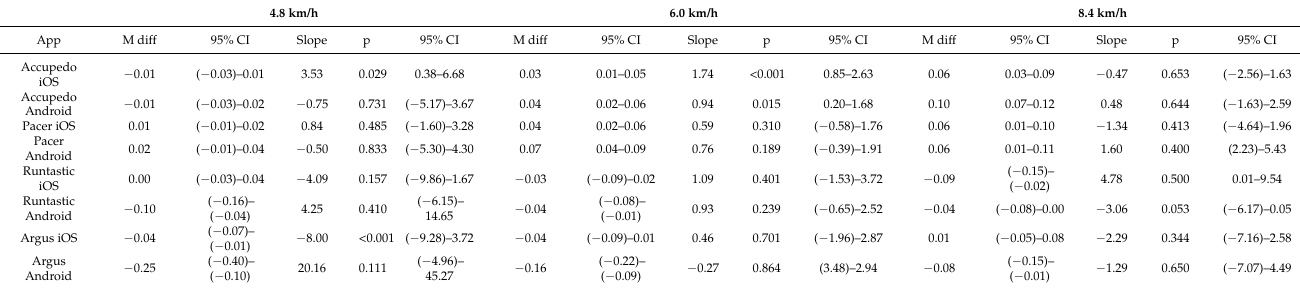
Figure 2. MAPE (% km) of PA monitors and apps compared with criterion measure. Bland–Altman results for distance for the three conditions are presented in Table 5, and all Bland–Altman plots are included in Figures S1–S48. For walking at 4.8 km/h, the plots revealed the narrowest 95% limits of agreement for Runtastic iOS (difference = 0.00 km) and Sports Tracker (difference = − 0.01 km), and slightly wider values for Accupedo (difference = − 0.02 km) and Accupedo iOS, Accupedo Android, and Pacer iOS (difference = 0.01 km), while values were the widest for Runtastic Android (difference = − 0.10 km) and Argus Android (difference = − 0.25 km). During walking at 6.0 km/h and jogging at 8.4 km/h, the narrowest 95% limits of agreement were observed for Accupedo iOS and Runtastic iOS at 6.0 km/h (difference = 0.03 km) and for Argus iOS (difference = 0.01 km) and Runtastic Android at 8.4 km/h (difference = − 0.04 km). The widest values were observed for Argus Android at 6.0 km/h (difference = − 0.16 km) and Accupedo Android at 8.4 km/h (difference = 0.10 km). In general, the slopes for the fitted lines were not statistically significant (p < 0.05), suggesting that there were no significant patterns of proportional systematic bias for these apps, except for Accupedo iOS during walking at both speeds (p = 0.029 and p < 0.001, respectively), Argus iOS at 4.8 km/h (p < 0.001), and Accupedo Android at 6.0 km/h (p = 0.015). Table 5. Distance Bland–Altman results at various